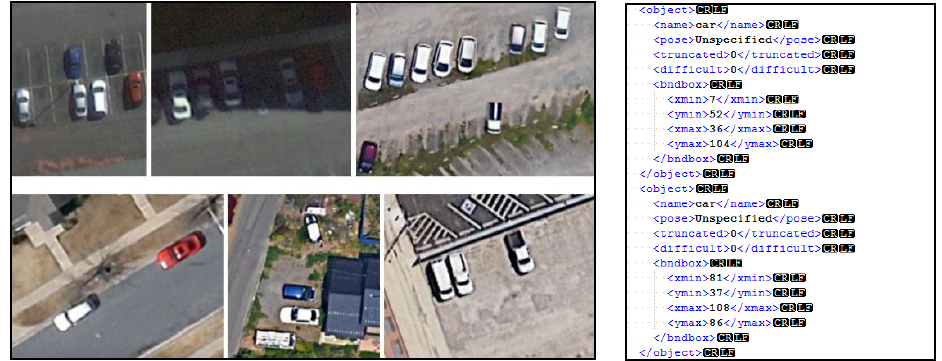
Figure 11. Partial samples and labels.